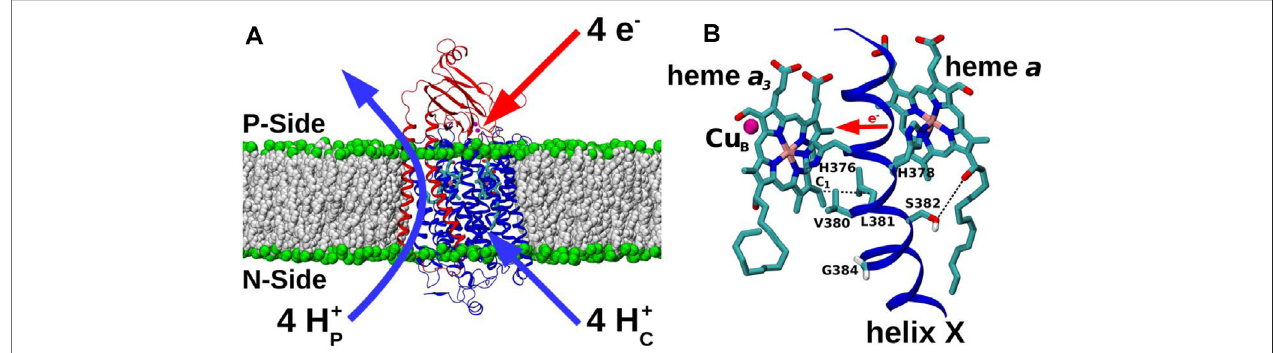
FIGURE 1 | C c O and TMH X of catalytic subunit I. (A) Subunit I (blue) and II (red) of C c O from yeast Saccharomyces cerevisiae (PDB 6HU9) embedded in a POPC lipidbilayer(greyandgreenspheres).Redox-activecentersareincluded,andtheoverallprotontransfers(H + P – pumpedprotons;H + C – substrateprotons)associatedwith a full four-electron catalytic cycle are indicated. P-side: positively-charged intermembrane space; N-side: negatively-charged mitochondrial matrix. (B) Redox-active cofactors of yeast C c O, heme a 3 and heme a and their ligands H376 and H378, respectively, from TMH X ofsubunit I are shown. Cu B (magenta sphere) and heme a 3 form the BNC. Residues V380, L381, S382, and G384 are labelled. S382 sidechain oxygen – heme a hydroxyl oxygen and L381 C β – heme a 3 vinyl C 1 distances are indicated by dashed black lines. Forward direction of heme-heme electron transfer is marked with a red horizontal